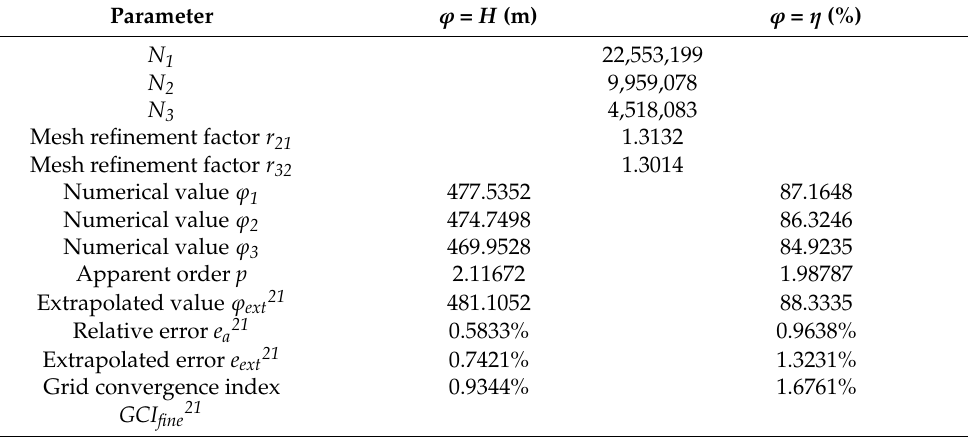
Table 3. Grid independence validation.